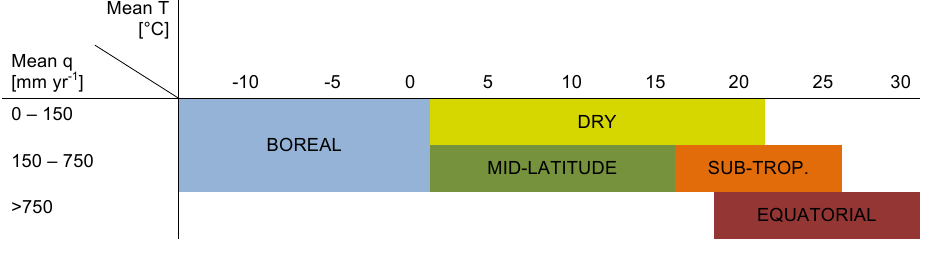
Table 2. Datasets used for the hydrobelt delineation and analysis.